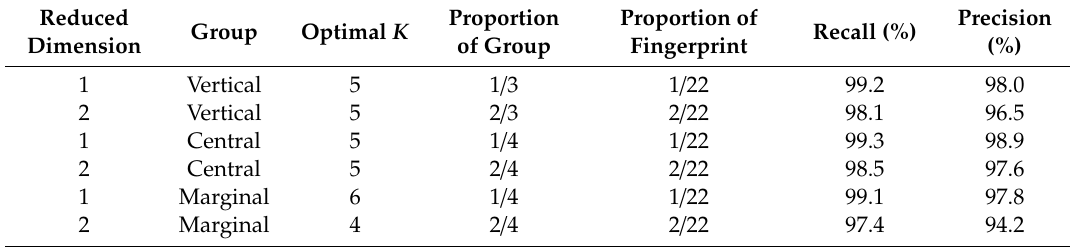
Table 4. None horizontal dimensionality reduction